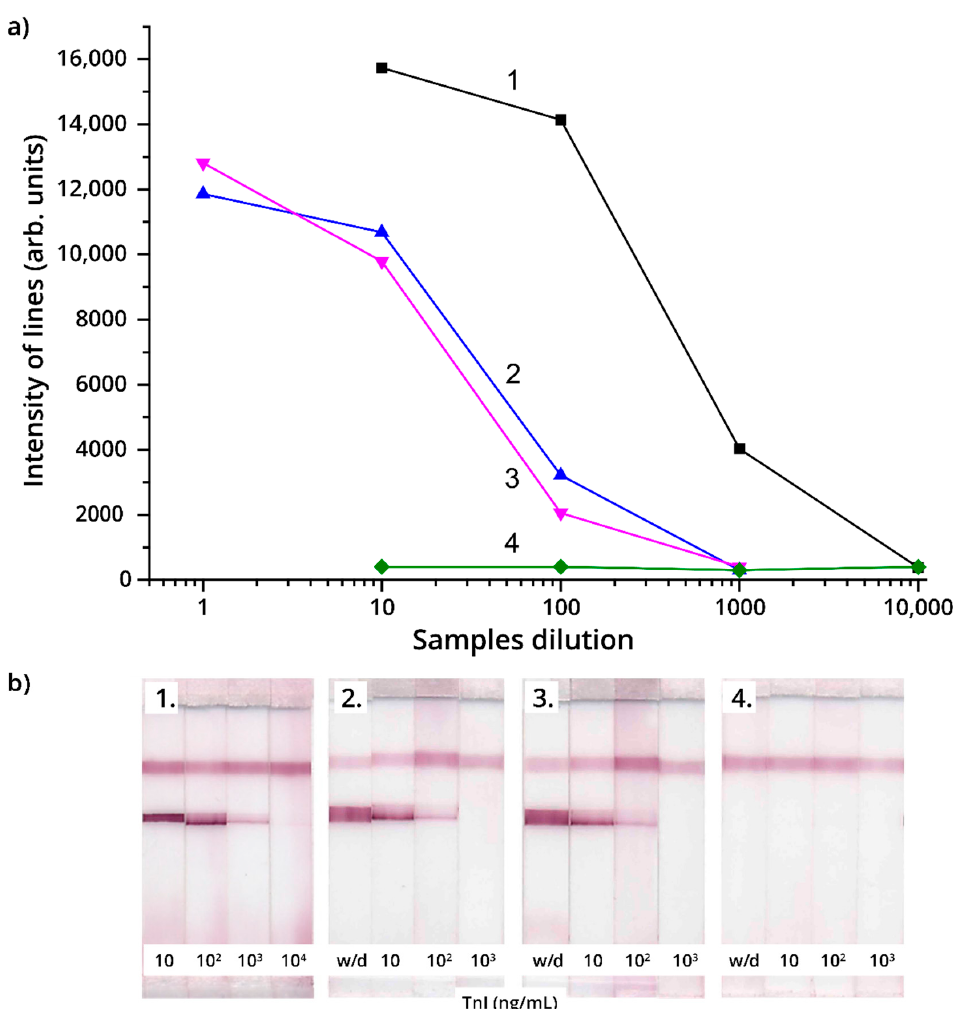
Figure 8. ( a ) Relationship between analytical zone color intensity (arb. units) and meat product sample dilution; ( b ) appearance of the test strips: 1—beef extract (Variant No. 2 of the test system), 2, 3—extracts from sausage samples (Variant No. 2 of the test system), 4—chicken meat extract (Variant